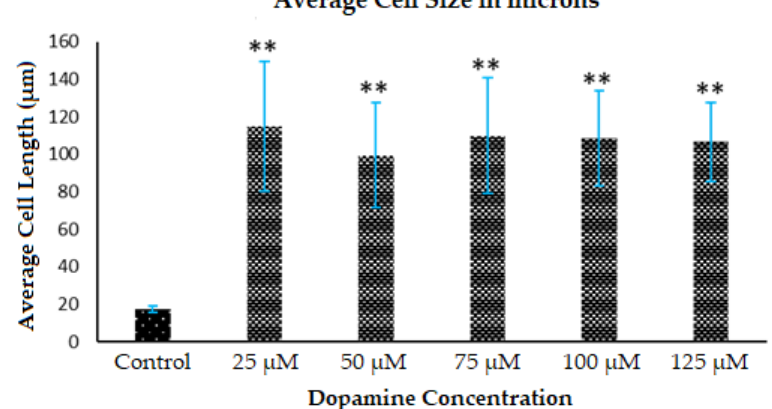
Figure 4. Morphology changes in the astrocyte cell body. Diffquik staining of the astrocytes was carried out to quantify the average cell size by 15 randomly selected astrocytes from randomly selected 3 fields in 2 wells of cultured cells respectively from 3 sets of different experiments treated with the indicated concentrations of DA which in turn formed PDA and the average of their summations were taken. Data represent multiple plating for each condition and ** denotes p < 0.01 compared to control condition for cell length analyzed.